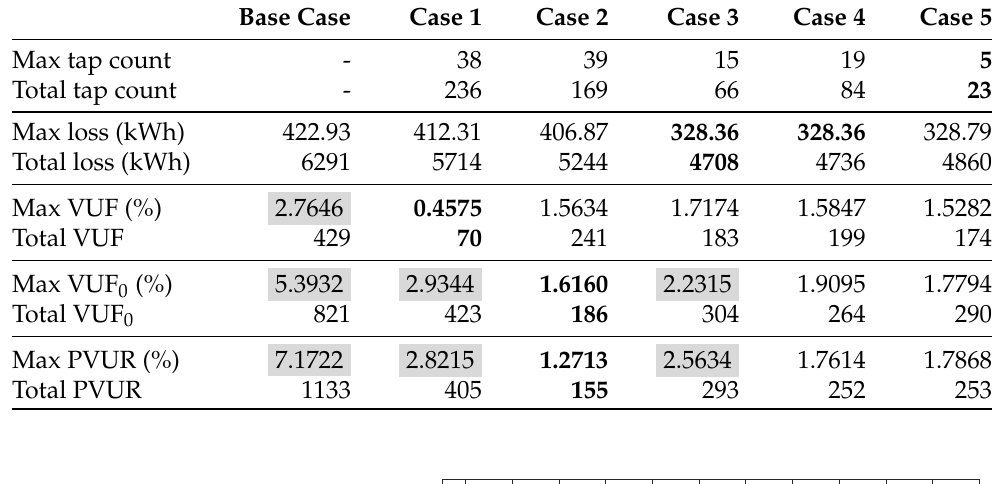
Table 1. Simulation results of unbalances, losses, and tap operations for all cases; the smallest values are shown in bold, and overlimit values are shaded.